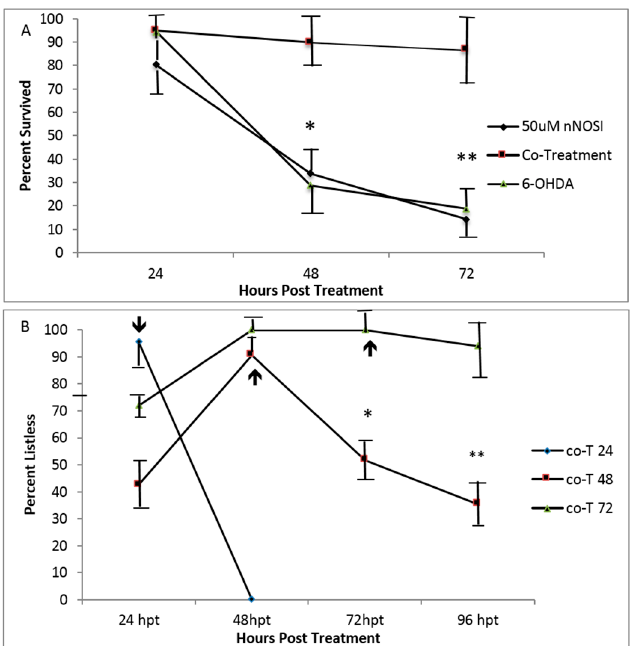
Figure 4. Analysis of the ability of 6 dpf treated fish to recover from 6 OHDA, nNOSI, and nNOSI + 6 OHDA co-treatments under various conditions. ( A ) Shows how the co-treatment (nNOSI + 6 OHDA) elicits listless/PD-like symptoms with significantly greater survival than that of single treatments of either 6 OHDA or nNOSI (* p < 0.0001). Specifically, by 72 h of treatment only 10%–20% of either 6 OHDA and nNOSI fish survived their respective treatments. However, approximately 90% of co-treated fish survived (** p < 0.0001) during the same time period; ( B ) the effect of co-treatment duration periods on washout recovery from the listless phenotype. The fish that were exposed to the co-treatment for 24 h then washed out the next day (Co-T 24) had all returned to a normal state after being nearly 100% listless the day before. Fish that were washed out after being in the same co-treatment solution for 48 h (Co-T 48) spiked at the 48 h mark (approximately 90% listless) then after washout steadily recovered over the next 48 h but more slowly than the Co-T 24 fish reaching only a 40% recovery rate. The samples that were washed out after 72 h of co-treatment (Co-T 72) were 100% listless by the second day and stayed there until wash out on day 3. However, only approximately 10% recovered to their normal state at 24 h post washout. In conclusion, Co-T 24 fish completed recovered from ERS washout, In contrast, Co-T 48 fish recovered more slowly than the Co-T 24 group (* p < 0.001) but faster than the co-T 72 h washout fish (** p < 0.001). Arrows indicate time of co-treatment washout. Bars equal ±